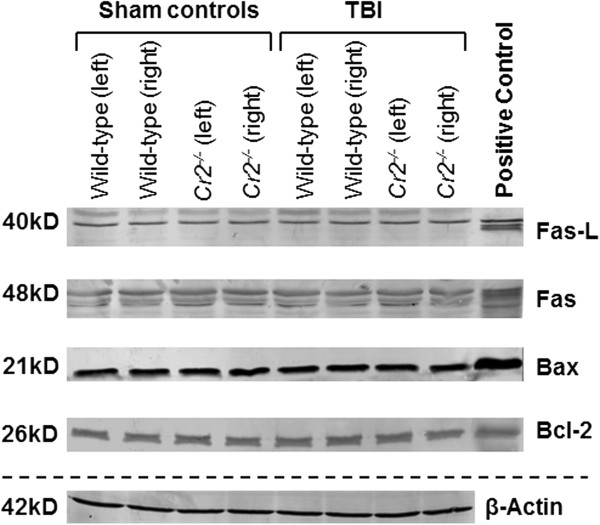
Selected pro- (Fas, FasL, and Bax) and anti-apoptotic (Bcl-2) mediator levels in brain homogenates. Samples were analyzed by western blots of injured (left) and non-injured (right) hemispheres at seven days after traumatic brain injury (TBI) or sham operation. Equal concentrations of protein (50 μg per lane) were loaded on SDS-Page, and consistent loading was confirmed by β-Actin control blotting. Mouse-specific primary antibodies against Fas, FasL, Bax, and Bcl-2 were used on nitrocellulose membranes and visualized by a colorimetric assay using alkaline-phosphatase. No differences in mediator levels were detected between the groups at any time-point assessed.